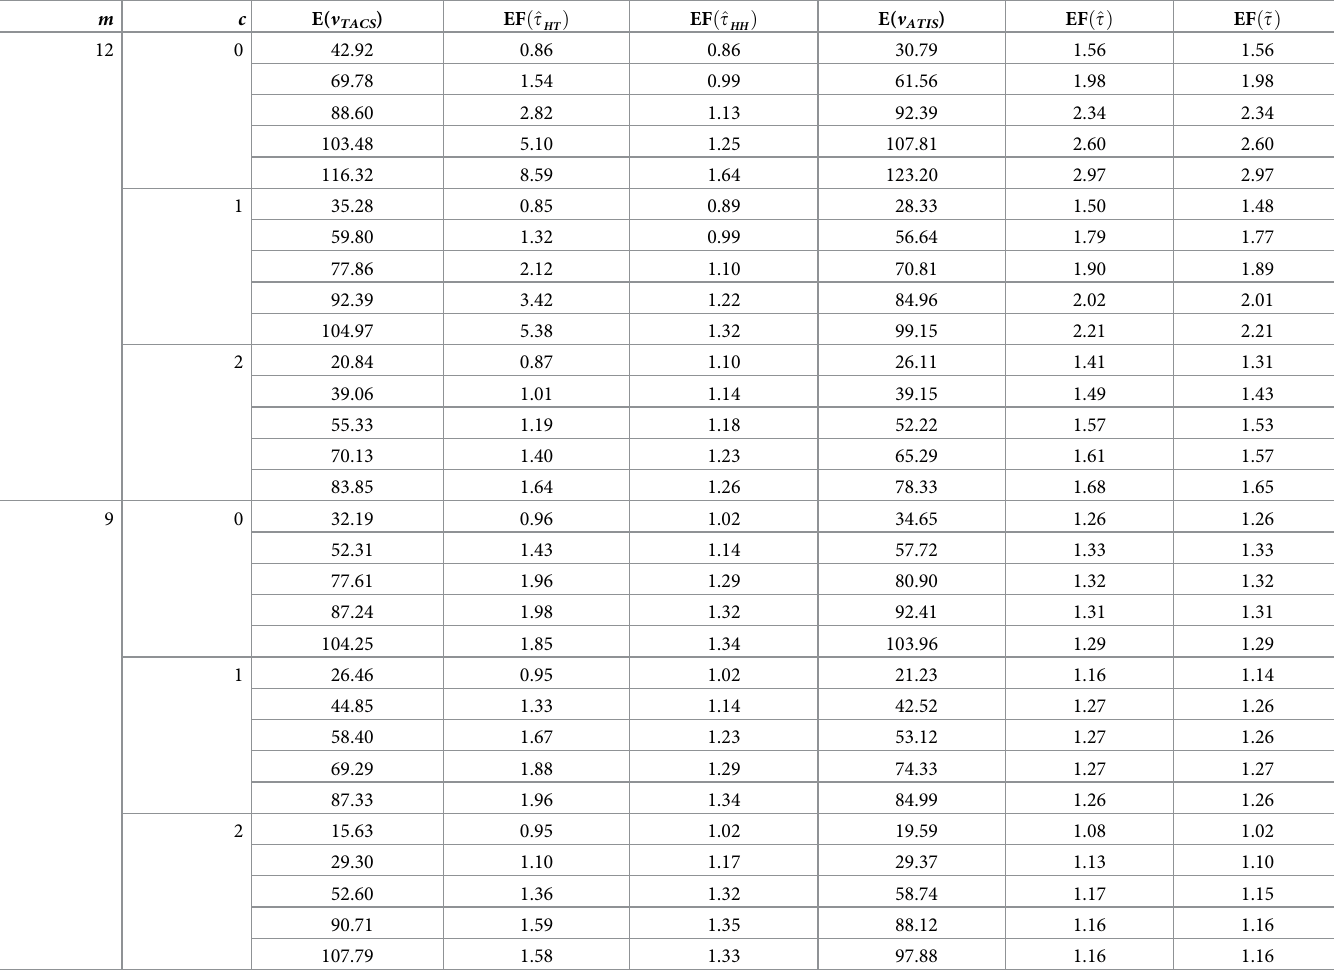
and ^ t for TACS are computed for the buttercups population. They are computed for m = 9, 12 and HT HT